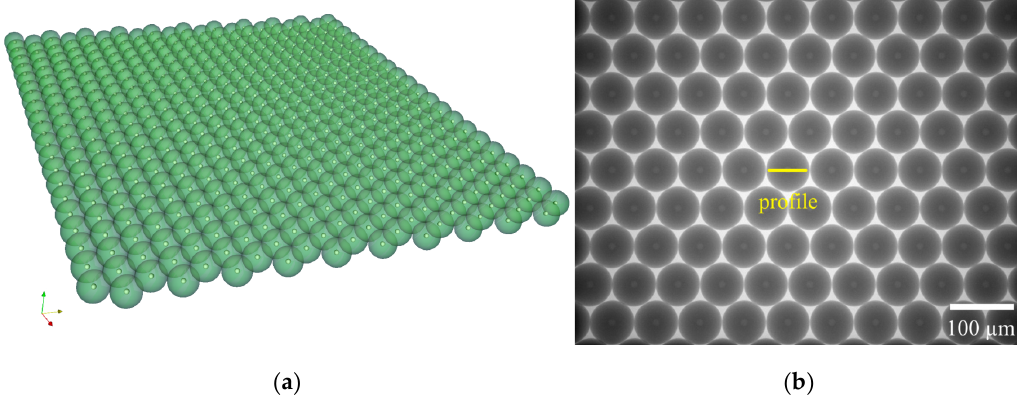
Figure 3. Representation of a single layer of a 21 × 21 arrangement of metallic particles of 50 µm in diameter and with 5 µm air-filled pores inside, taken from the aRTist simulation scene ( a ). Radiographic image of the identical geometry with the profile (yellow inset) to investigate the visibility as function of CNR ( b ). The pores are the light gray areas in the center of the spheres.